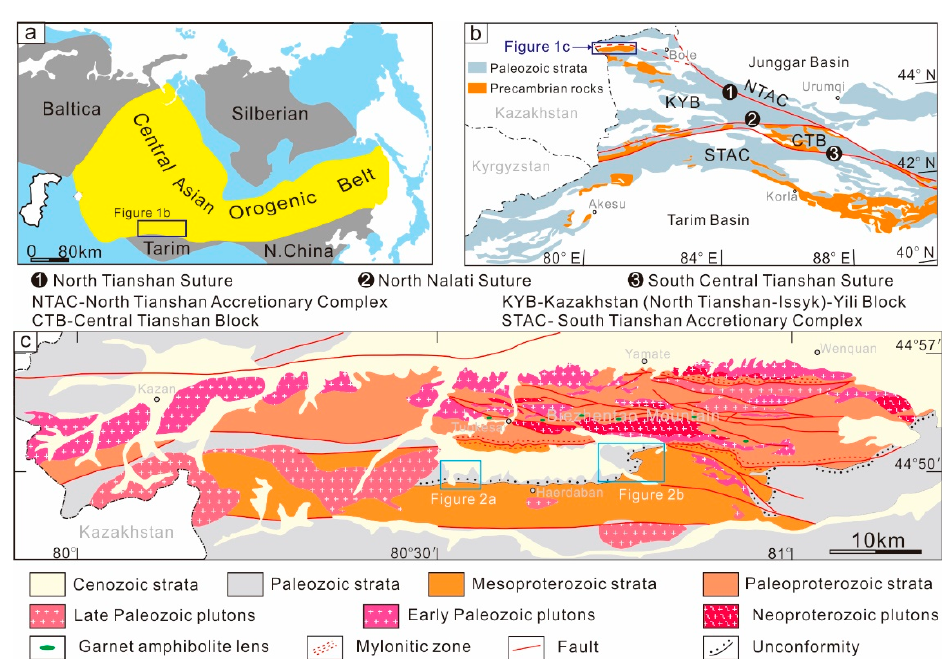
Figure 1. ( a ) Simplified map of the Central Asia Orogenic Belt and the location of the Tianshan orogen (modified after [32]). ( b ) Simplified geological map of the Chinese Tianshan belt (modified after [33]). ( c ) Geological map of the Biezhentao Mountain area and location of the study area (modified after [34–36]).